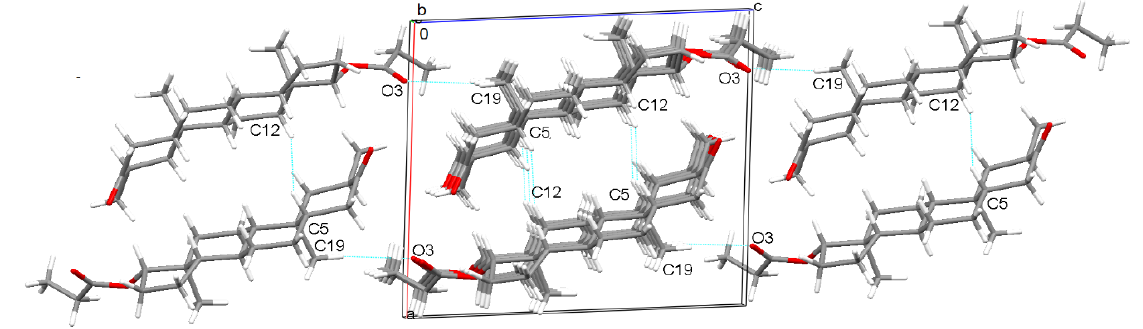
Figure 4. Unit cell packing diagram illustrating the arrangement of Drost 2 molecules.